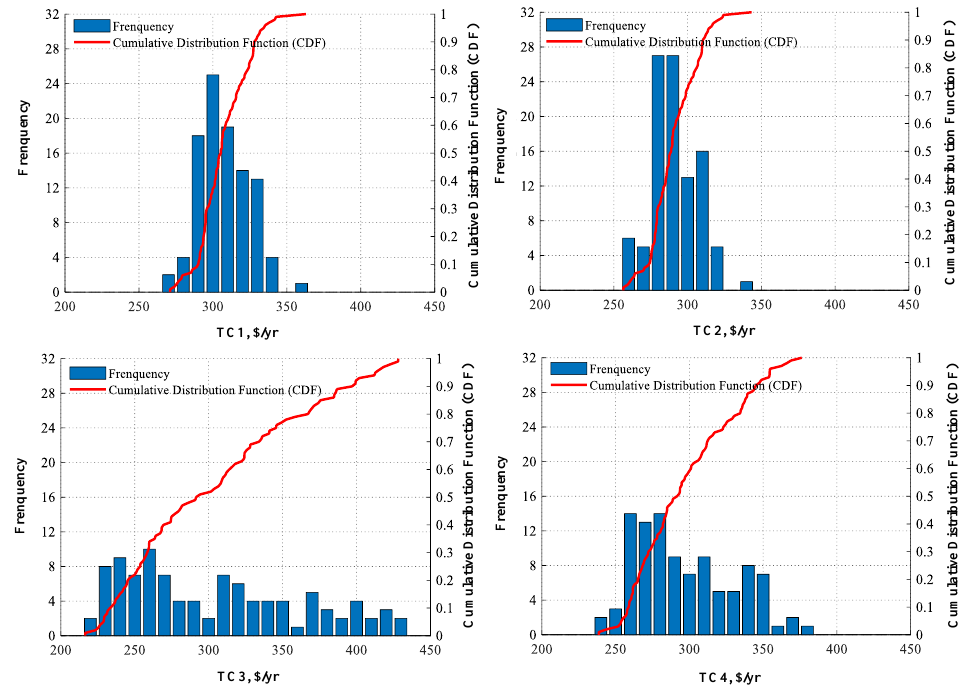
Fig. 10. The cost allocated for 10 th Building under four cost allocation models TC 1, TC 2, TC 3, TC